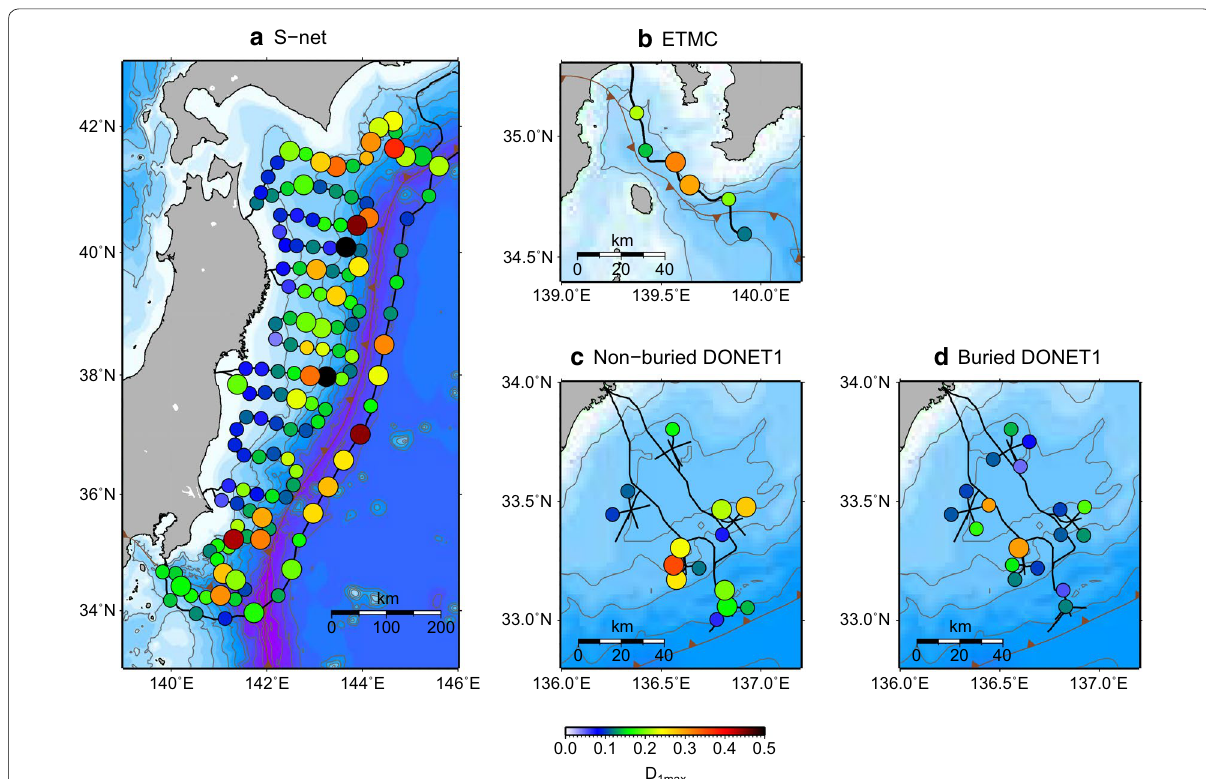
Fig. 14 Same figure as Fig. 5 except that only the earthquakes satisfying the 45